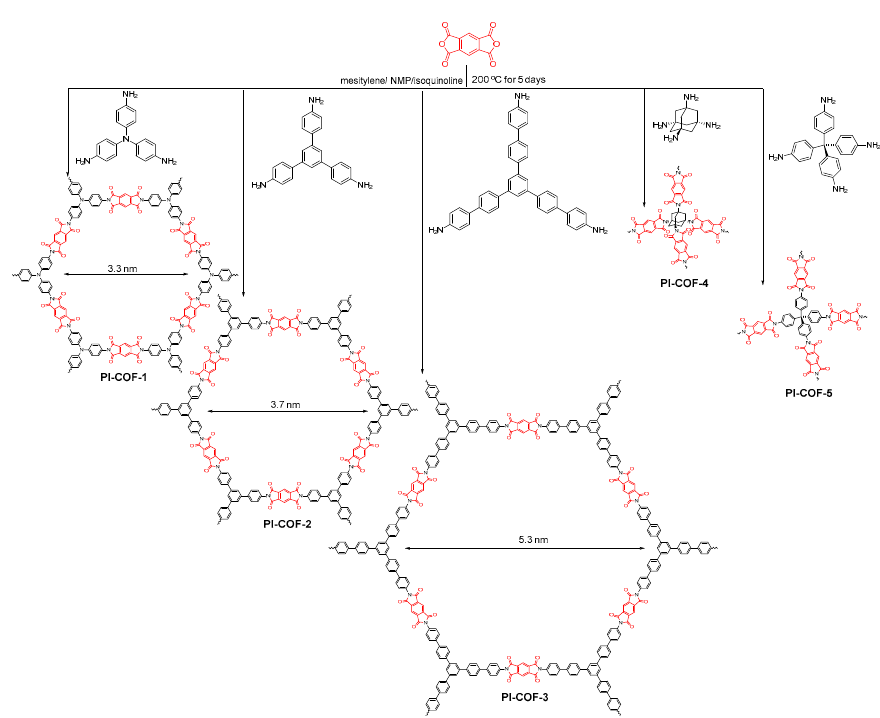
Figure 22. Construction of imide-linked COFs by stitching tritopic or tetratopic polyaniline with